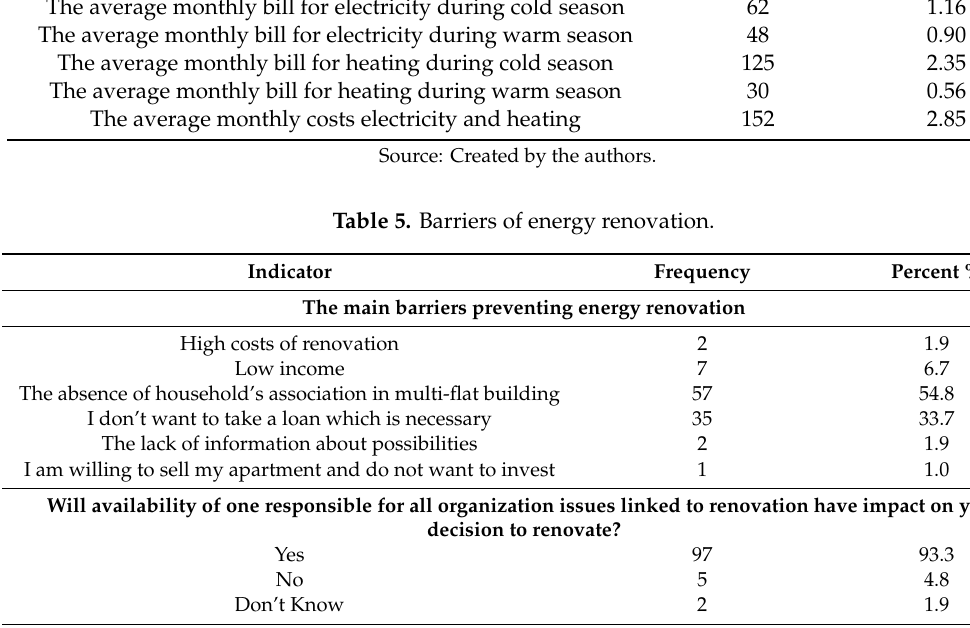
Table 4. Average monthly energy cost per m 2 taking into account the average apartment size of 53.3 m 2 . Indicator euro / month